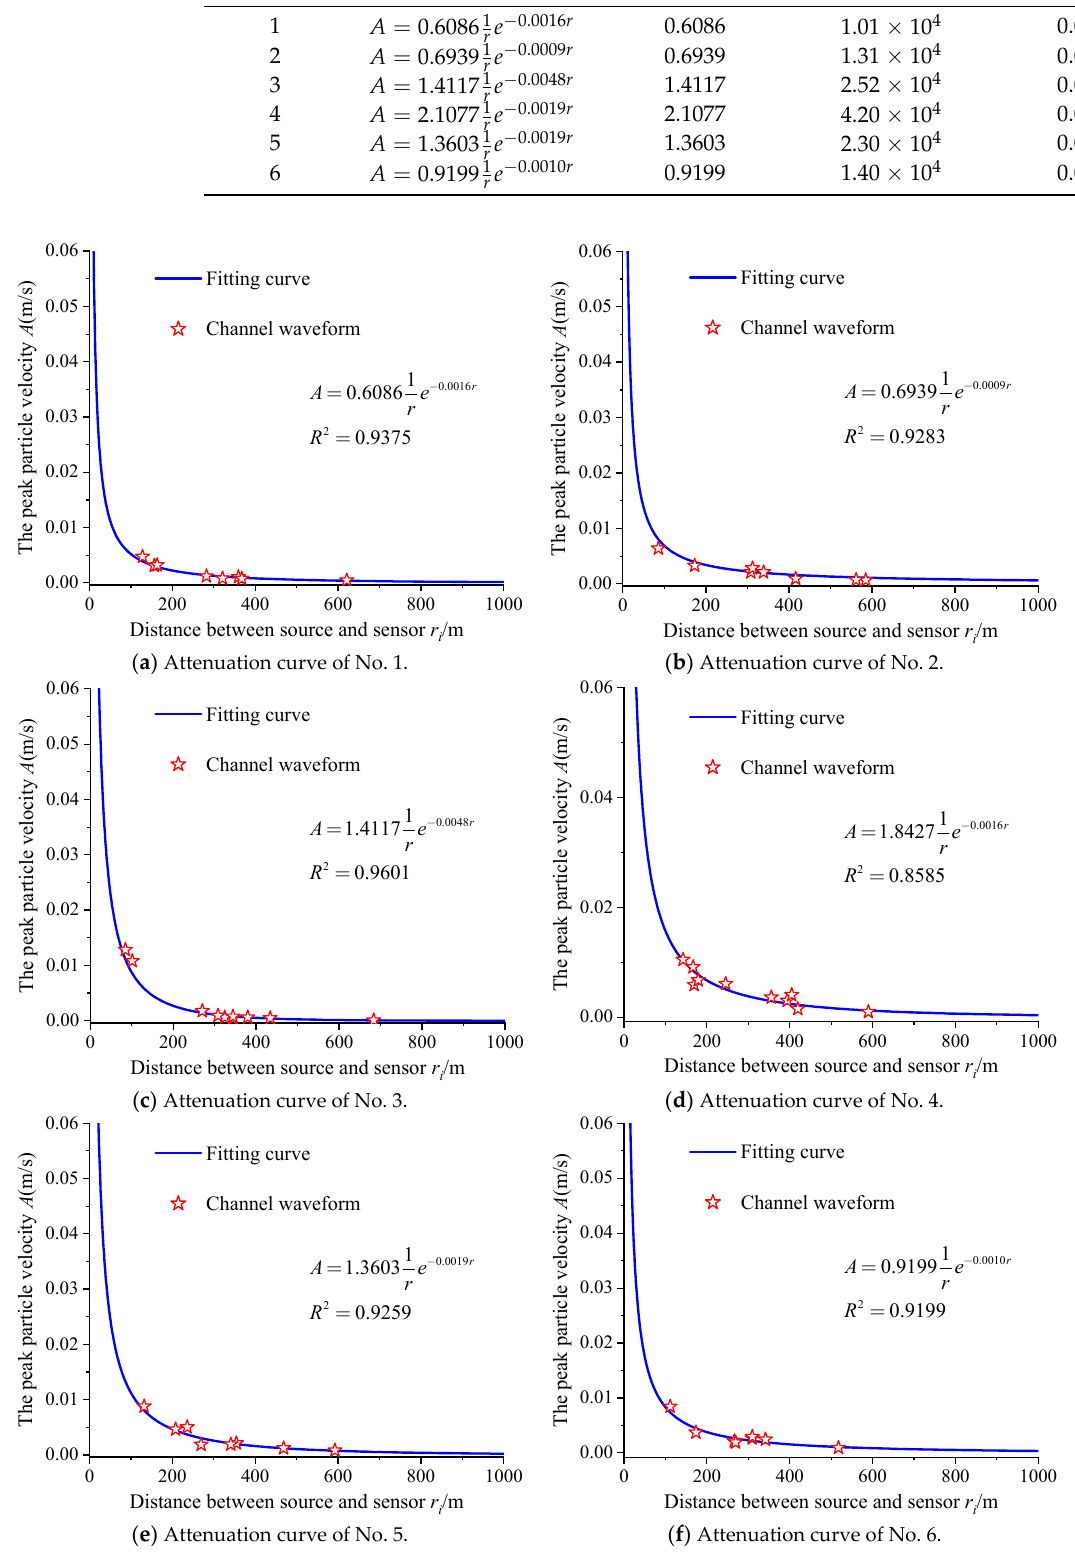
Figure 8. Mine earthquake attenuation curves.